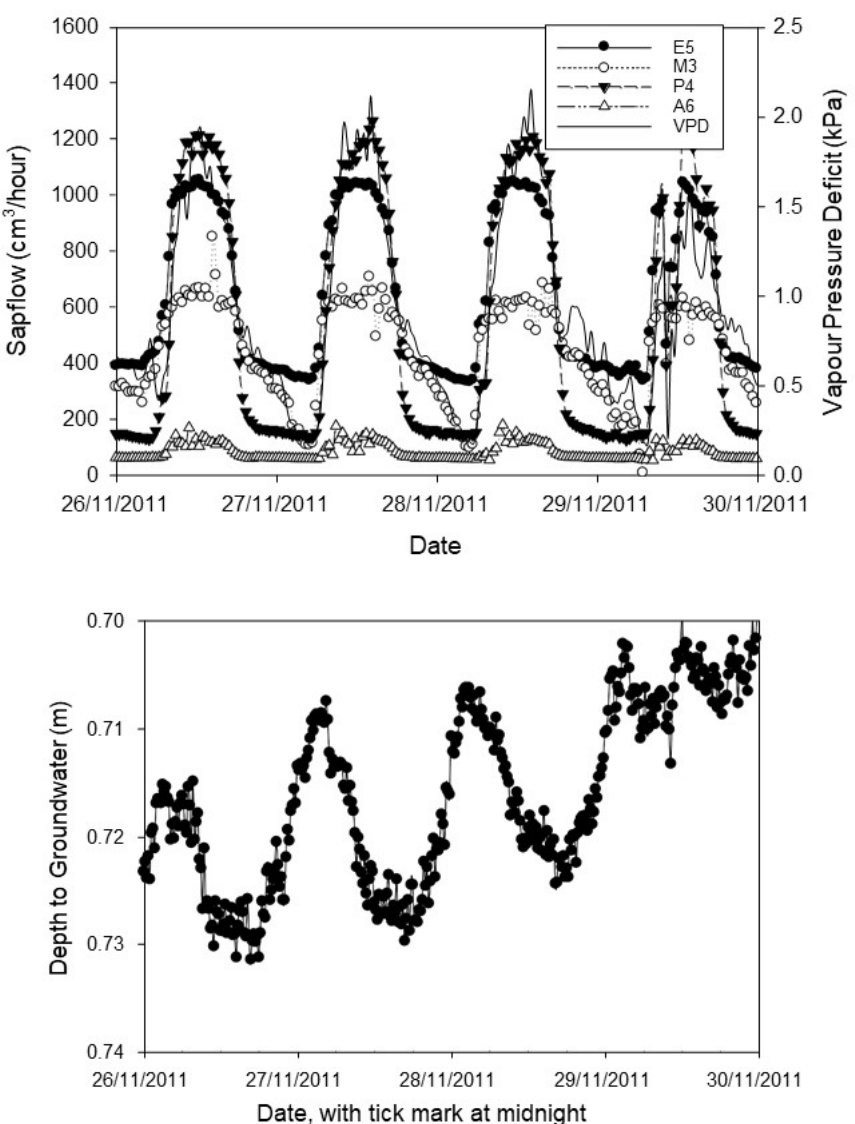
Figure 4. Diurnal fluctuations in sap flow for 4 of the trees monitored, vapor pressure deficit and depth to groundwater in November 2011.